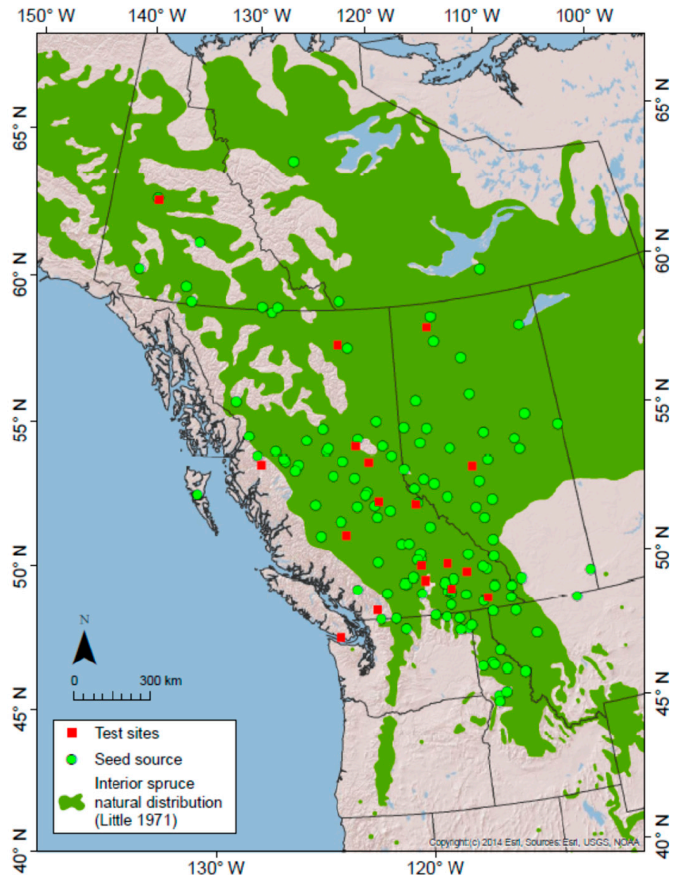
Figure 2. Seed source and test site locations used in the Picea glauca × engelmannii provenance trial. The High Level test site is located in northwest